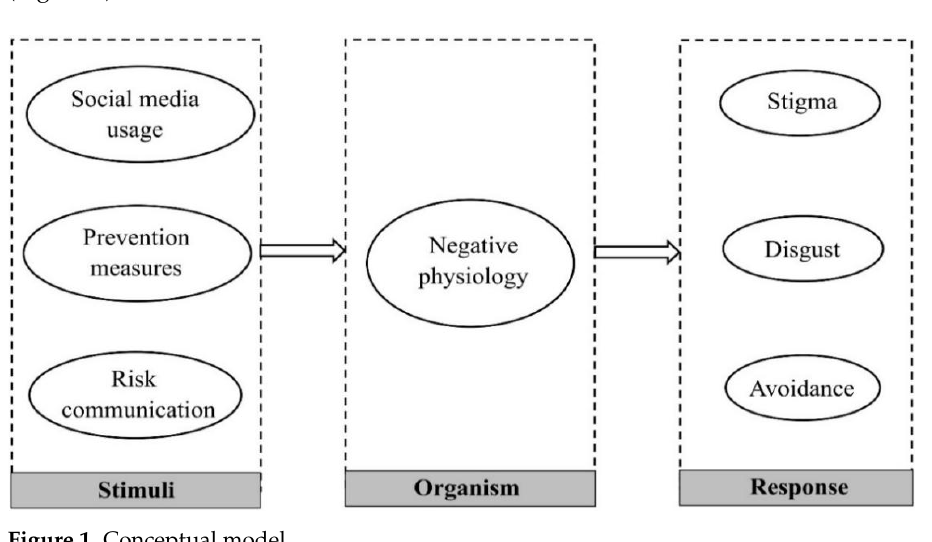
Figure 1. Conceptual model.